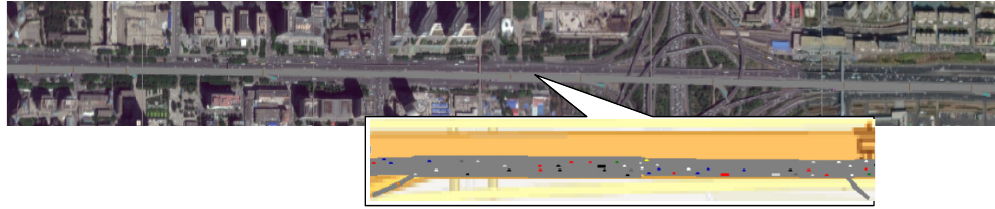
Figure 4. Topological representation of the Jingtong freeway segment in the VISSIM model.